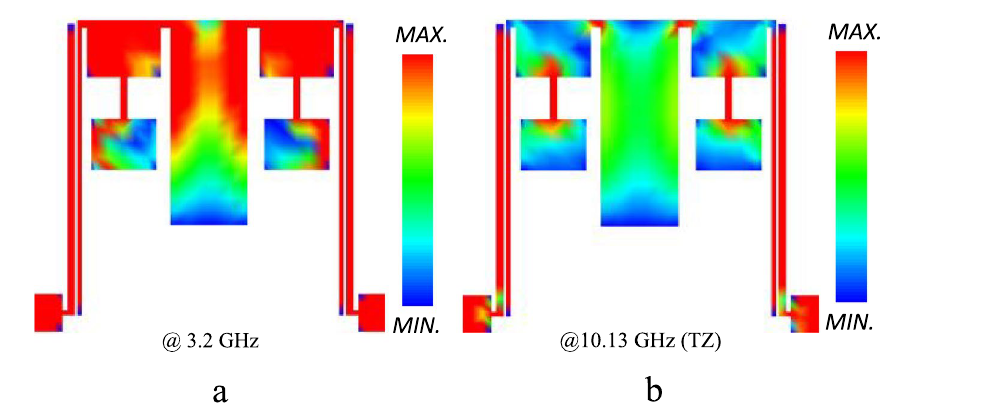
Figure 9. Current density distribution of proposed BPF: ( a ) 3.2 GHz, ( b ) 10.13